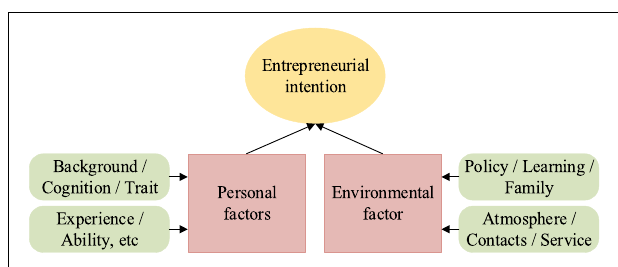
FIGURE 3 | Two-factor model.